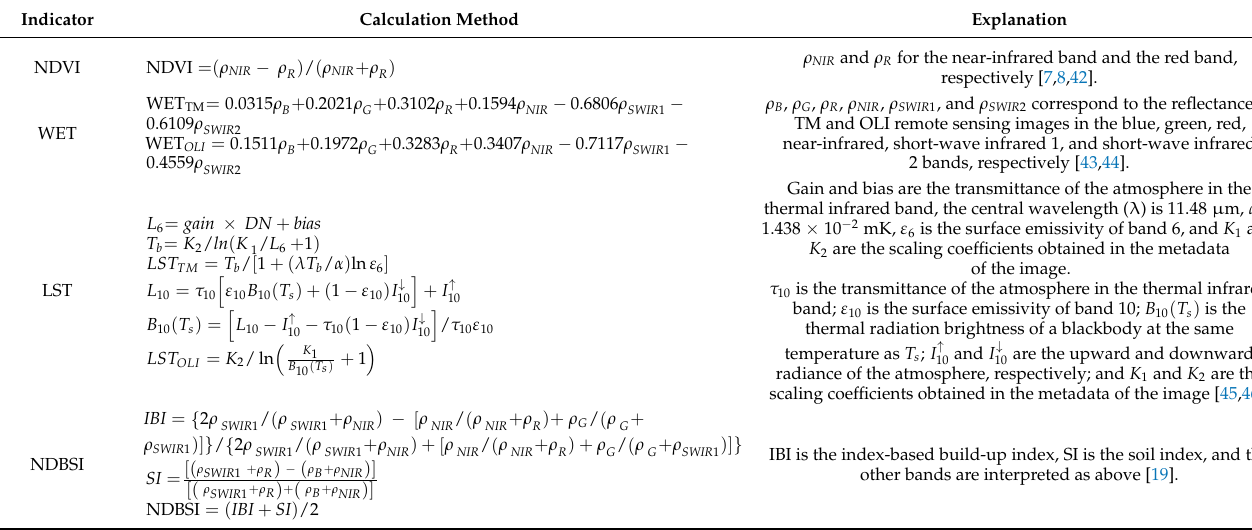
Table 2. NDVI, WET, LST, and NDBSI calculation formulae and